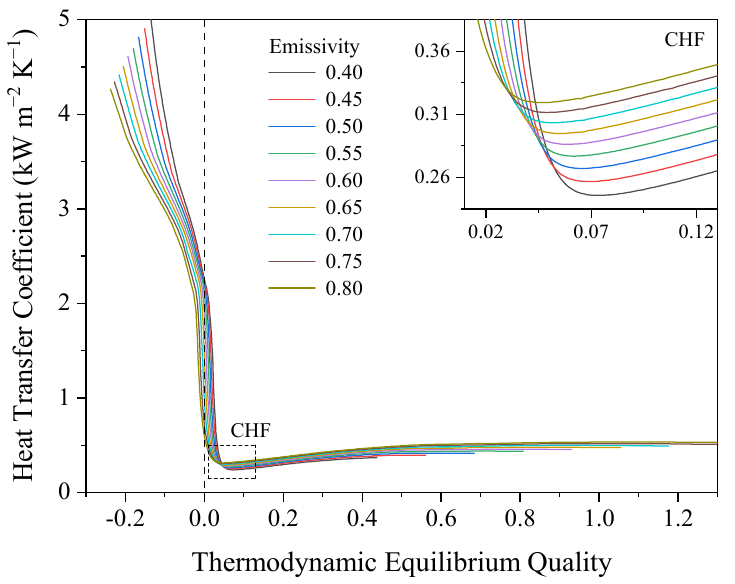
Figure 20. Heat transfer coefficient vs. thermodynamic equilibrium quality under wall emissivity of 0.40 to 0.80.